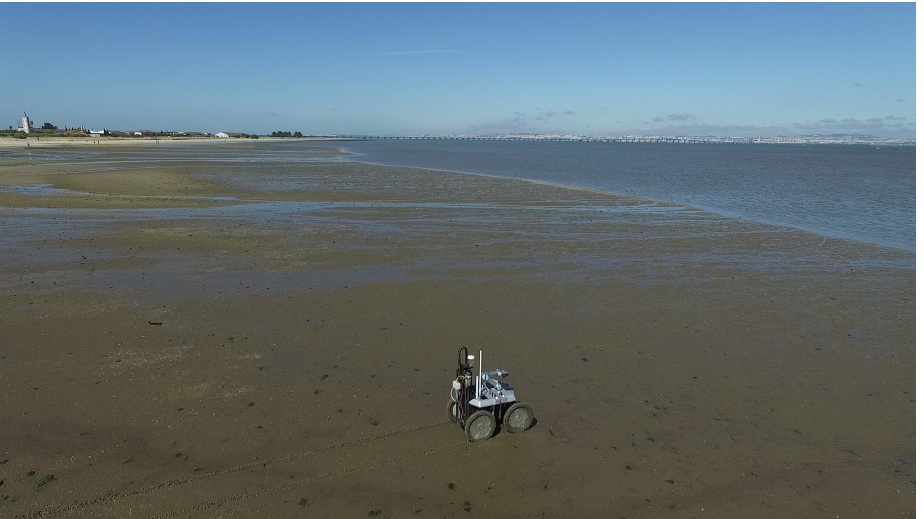
Figure 18. Monitoring mission execution with the aerial